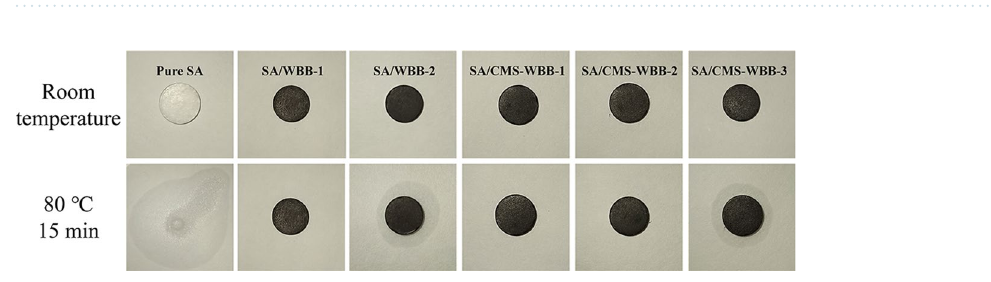
Figure 5. Leakage tests of SA, SA/CMS-WBB and